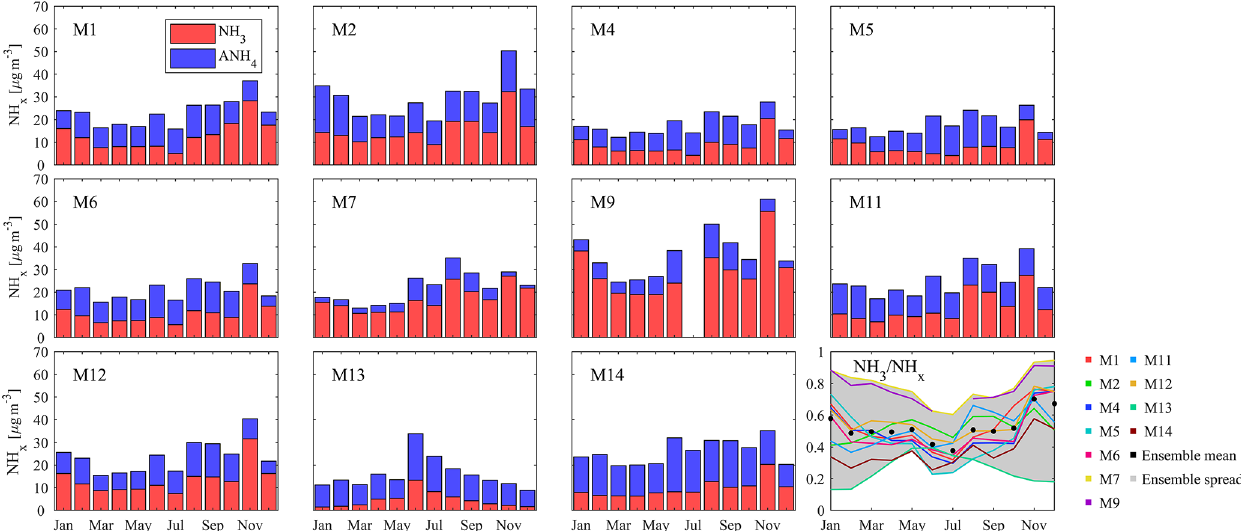
Figure 5. Time series of the multi-model-simulated total ammonium (NH x =NH 3 + NH + NH 3 to total ammonium, over the NCP region from January to December in the year